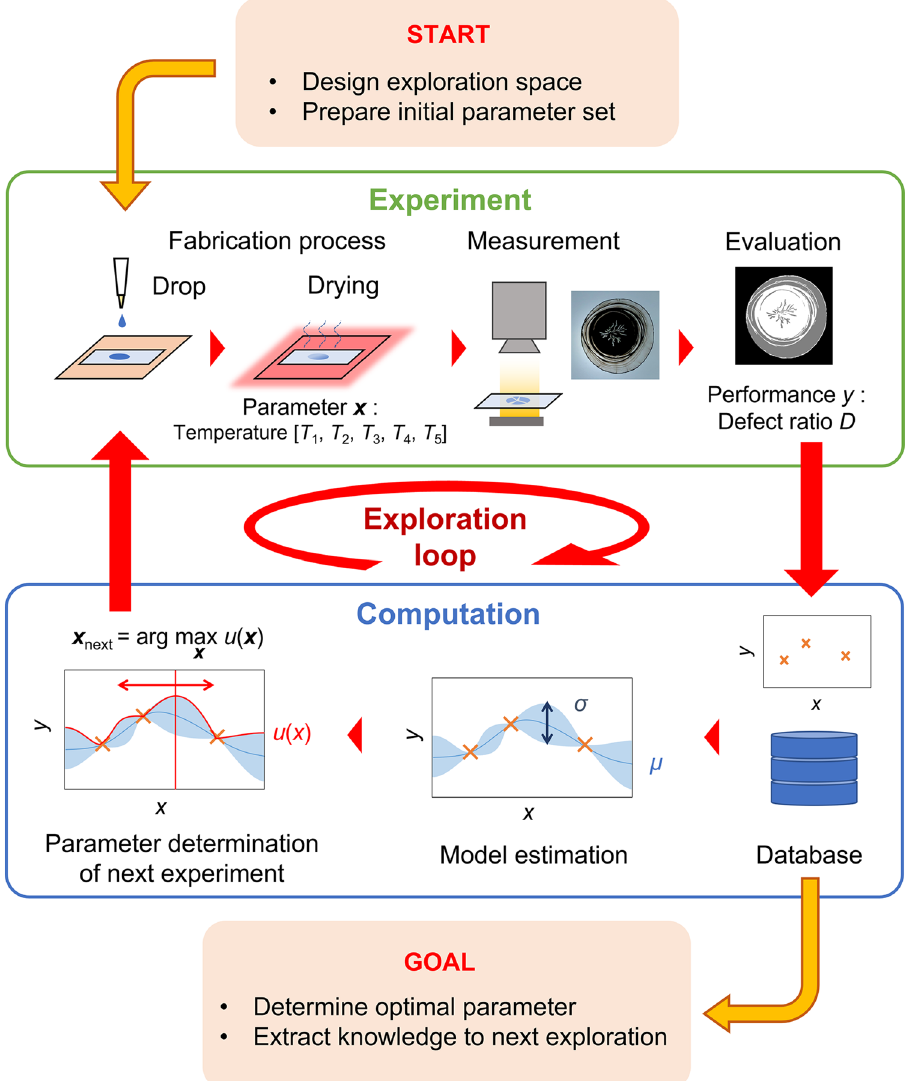
Figure 1. Overview of our process parameter exploration system using BO. First, the experiments were conducted under random parameters to collect data. The model was estimated with uncertainty, performance was predicted, and parameters for the next experiment were determined. The experiments were conducted using the proposed parameters, and we added the observed performance to the database. This loop was repeated to progress the